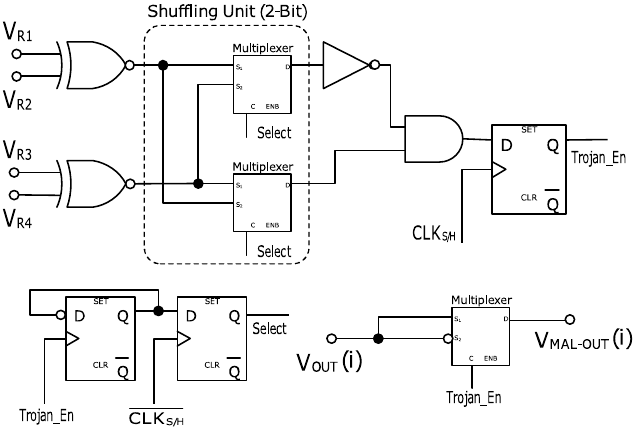
Figure 51. The circuit for the date ‐ path ‐ based attack.